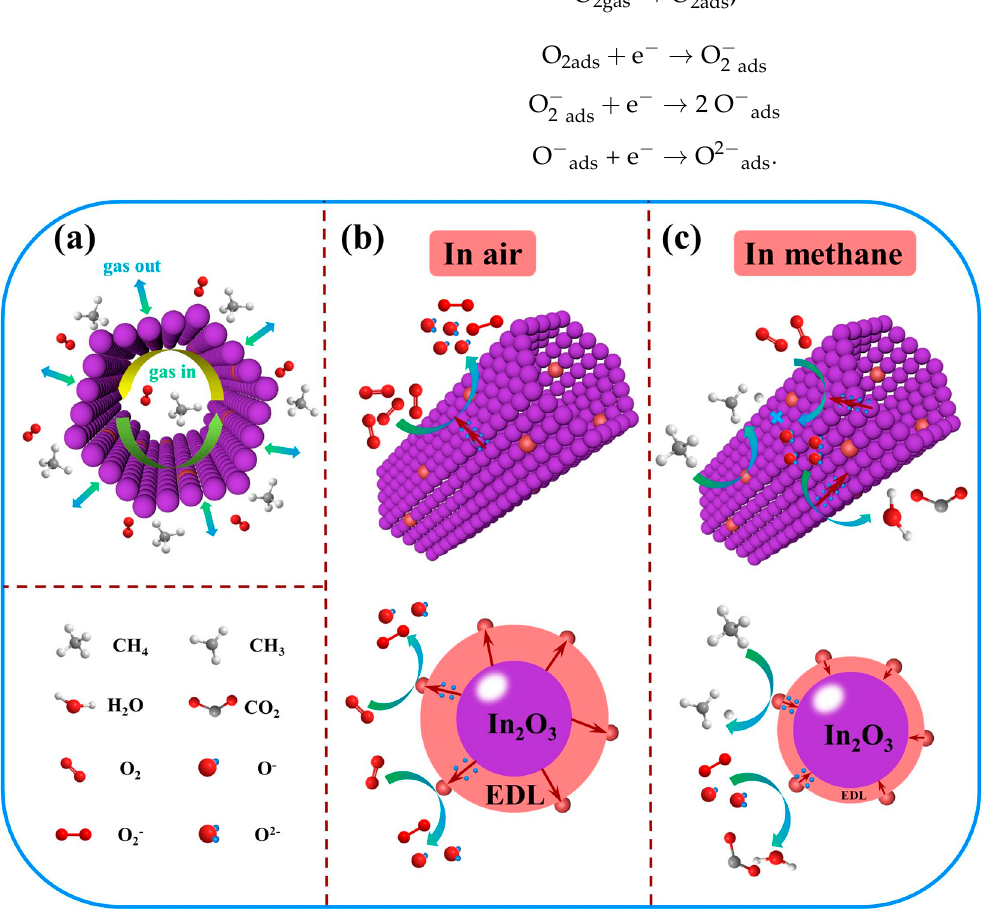
Figure 9. ( a ) The illustration of gas diffusion; Schematic diagram of methane sensing mechanism for Pd@In 2 O 3 -2 PHTs exposed to ( b ) air and ( c ) Pd@In 2 O 3 -2 PHTs exposed to ( b ) air and ( c ) methane.